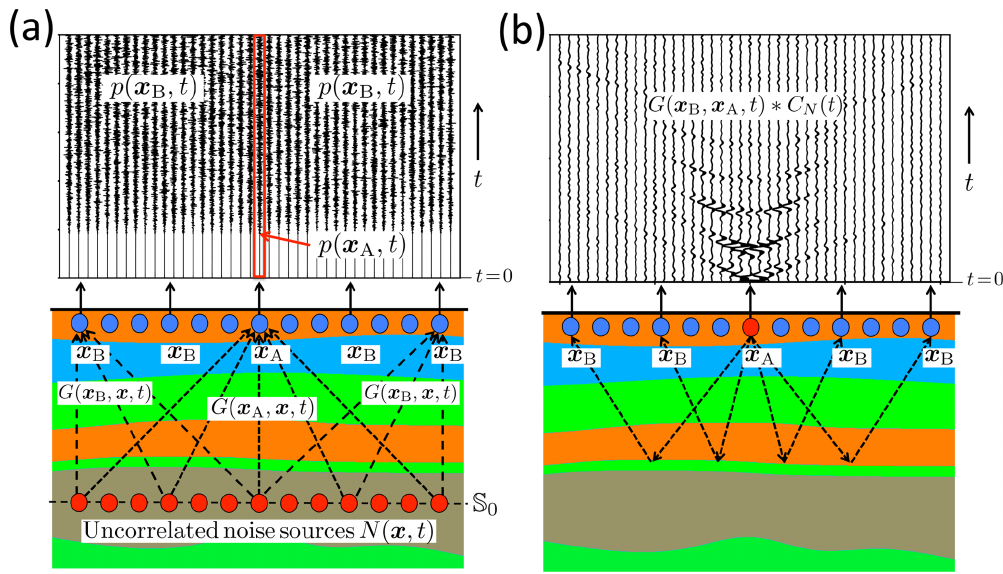
Figure 5. Seismic interferometry with body waves in a layered medium. The upper boundary is a free surface. (a) Noise observed by receivers just below the surface, due to uncorrelated noise sources in the subsurface (only the first 5s of approximately 5min of noise registrations are shown). (b) Retrieved reflection response, including multiple reflections.